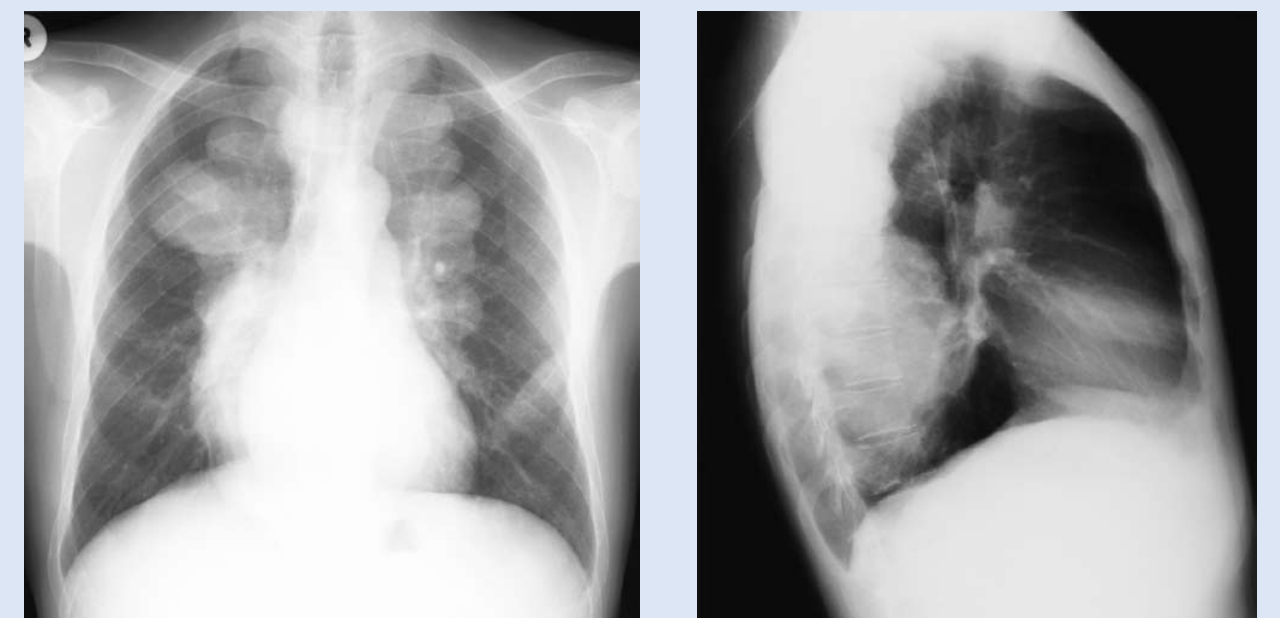
Fig. 1. Frontal and lateral radiographs of the chest show lobulated soft-tissue posterior mediastinal masses and medullary expansion of the ribs and clavicles with thinning of the